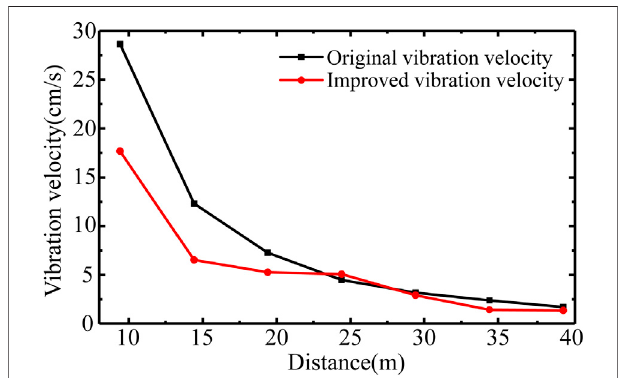
FIGURE 11 | Comparison of blast vibration